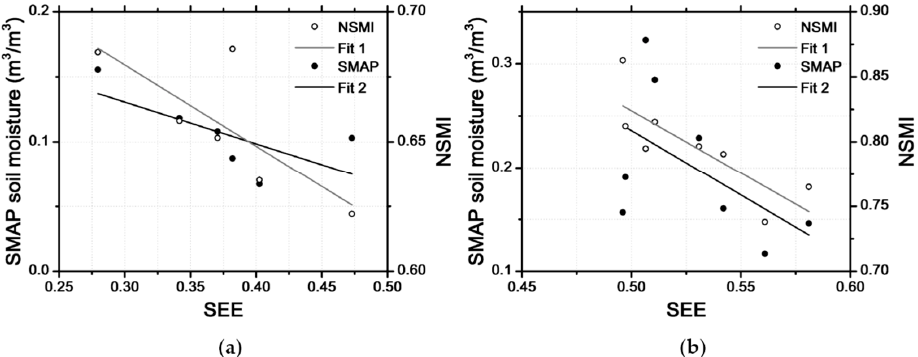
Figure 12. ( a,b ) Relationships of SMAP soil moisture and the NSMI related to soil evaporation efficiency (SEE).